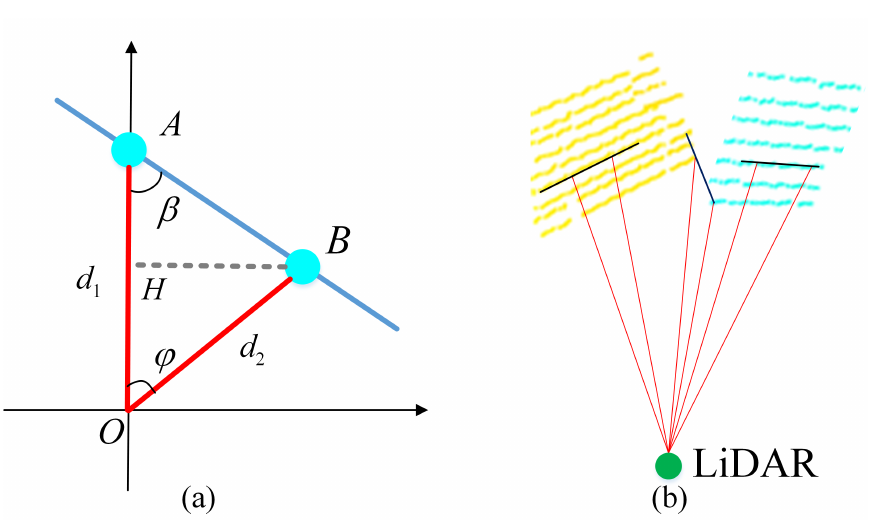
Figure 5. The schematic diagram of segmentation. ( a ) Whether two points are corresponded to the same object can be determined by evaluating the angle β . ( b ) shows an